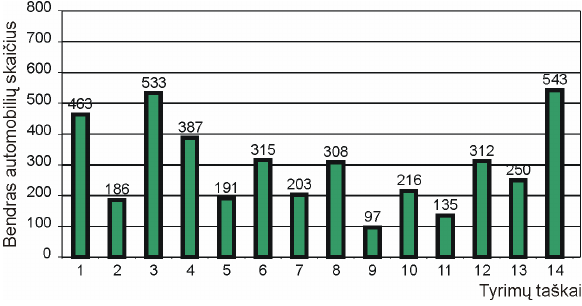
Fig. 2. Average number of vehicles (unit/h) at the point of